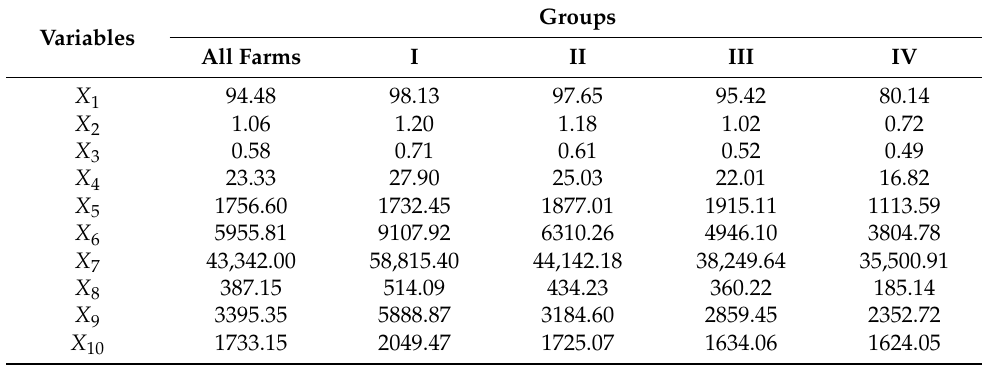
Table 7. Average values of the features for all researched farms and the distinguished classes.